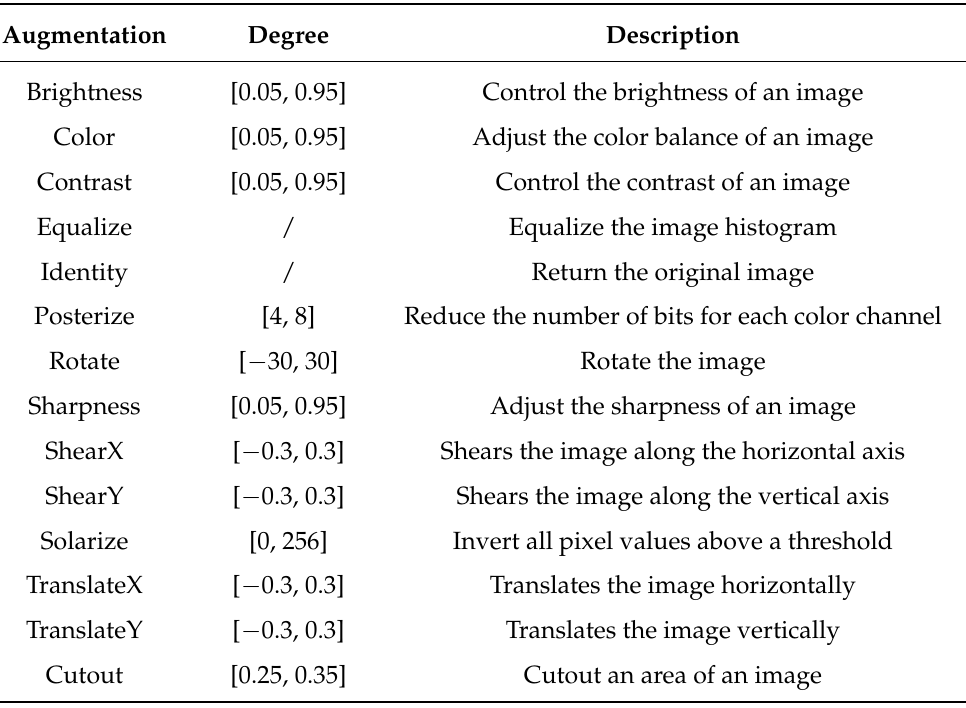
Table 1. Strong augmentation method, degree and description.